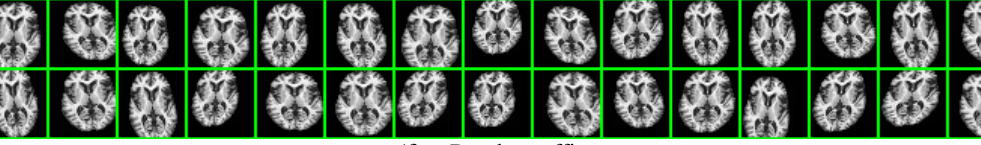
Fig. 10 Data augmentation results